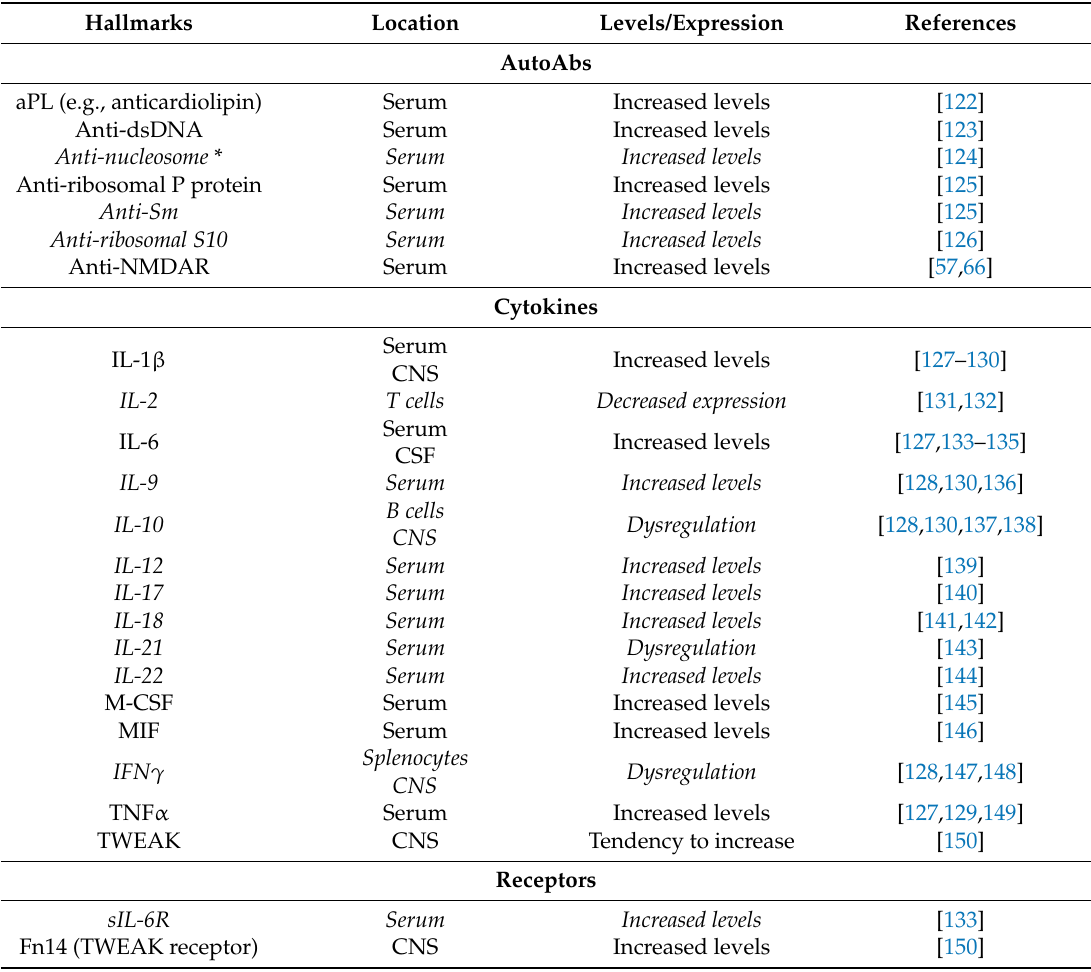
Table 2. Potential NPSLE biological hallmarks found in MRL/lpr